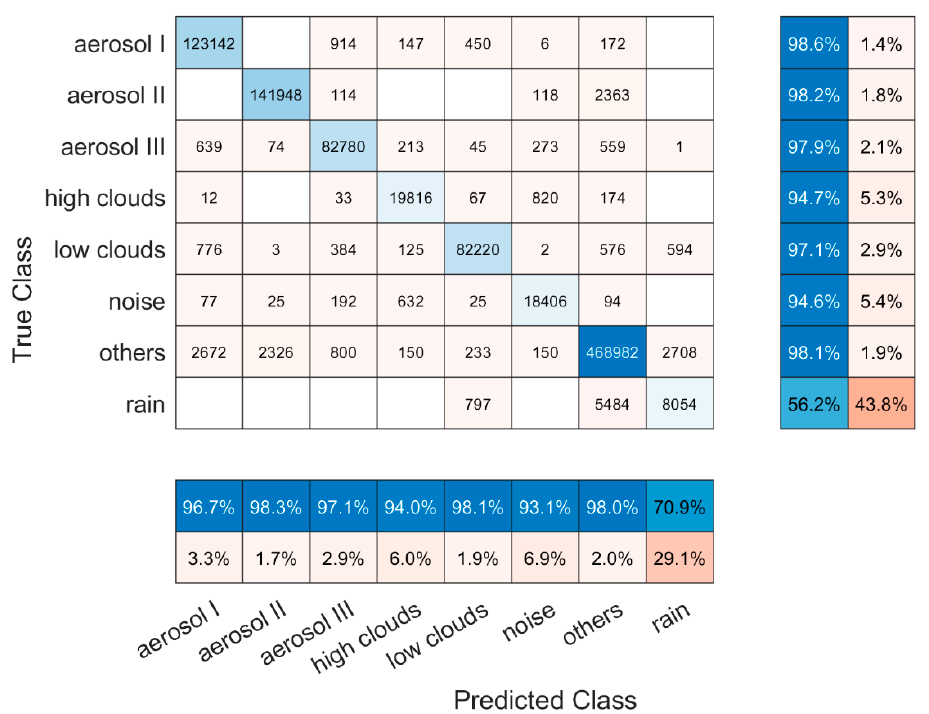
Figure 5. The evaluation of the noise discrimination model: the confusion matrix chart of the noise discrimination model with the testing data set, which is 90% of all data points. The number in the matrix is the count of data points for each class, blue colors indicate corrected predicted (TP), and red colors incorrectly predicted data (FN). Darker color means a higher percentage accordingly. The row summary is TPR (blue) and FNR (red) for each true class (row), respectively. The column is PPV (blue) and FDR (red) for each predicted class (column), respectively.